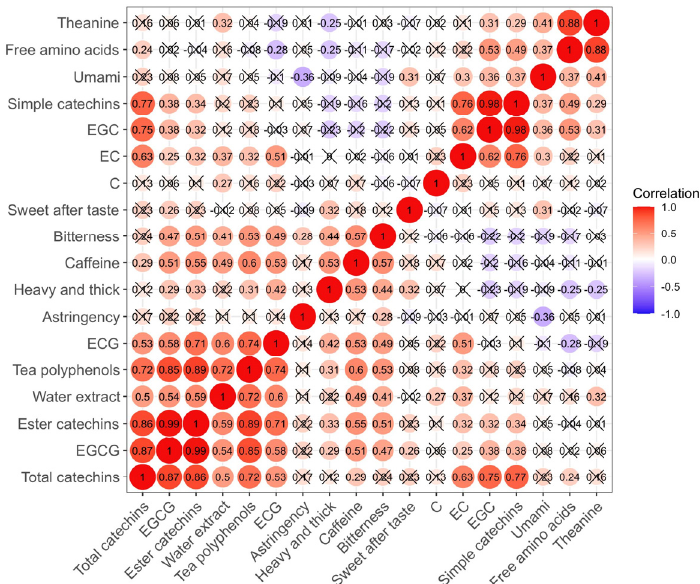
Figure 4. Correlation between taste sub-attributes and phytochemical compositions of Oolong tea. × indicates that the correlation is not significant at the level of p < 0.05. The numbers indicate the correlation coefficient, where positive numbers indicate positive correlation and negative numbers indicate negative correlation. Red indicates positive correlation, and blue indicates negative correlation.